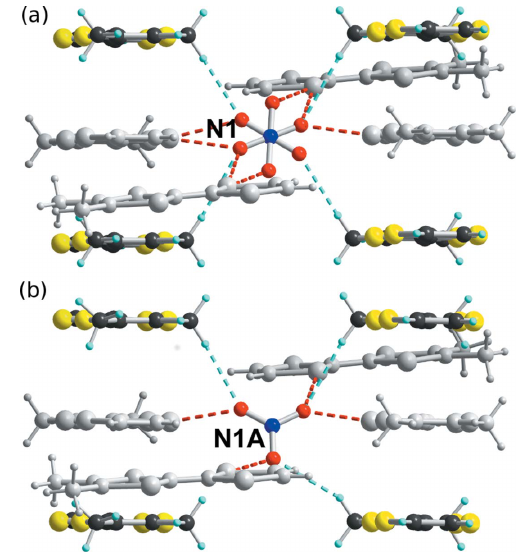
Figure 9 Details of the short S (cid:4)(cid:4)(cid:4) O interactions (red dashed lines) and weak C— H (cid:4)(cid:4)(cid:4) O hydrogen bonds (turquoise dashed lines) between the o -Me 2 TTF molecules and the NO 3 (cid:2) anion. ( a ) At 250 K. ( b ) In the intermediate q 1 = (0, 1 , 1 ) phase for the major NO 3 (cid:2) anion orientation on atom N1 A (see 2 2 Fig. 7). The o -Me 2 TTF molecules involved in S (cid:4)(cid:4)(cid:4) O interactions and C Me —H (cid:4)(cid:4)(cid:4) O hydrogen bonds are in grey and full colour, respectively.